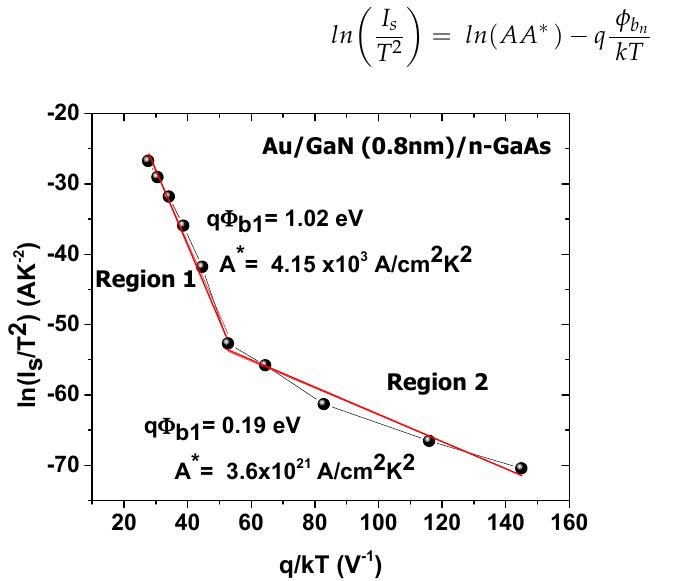
Figure 6. Variation of Richardson characteristic ln ( I s / T 2 ) versus q/kT . Red lines are linear fits of experimental data according to the root mean square method.